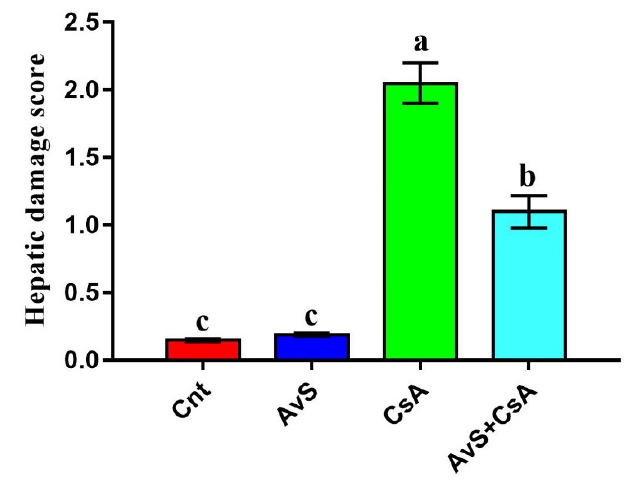
Figure 4. Photomicrographs of hepatic sections stained with H&E. Arrows refer to central veins, blue arrowheads refer to hepatic sinusoids, and black arrowheads refer to mononuclear cell infiltration. Scale bars: 50 μ m. The bar graph shows the hepatic damage score, and values are the mean ± SEM ( n = 3/group). Columns carrying different letters (a–c) are significantly different at p < 0.05.